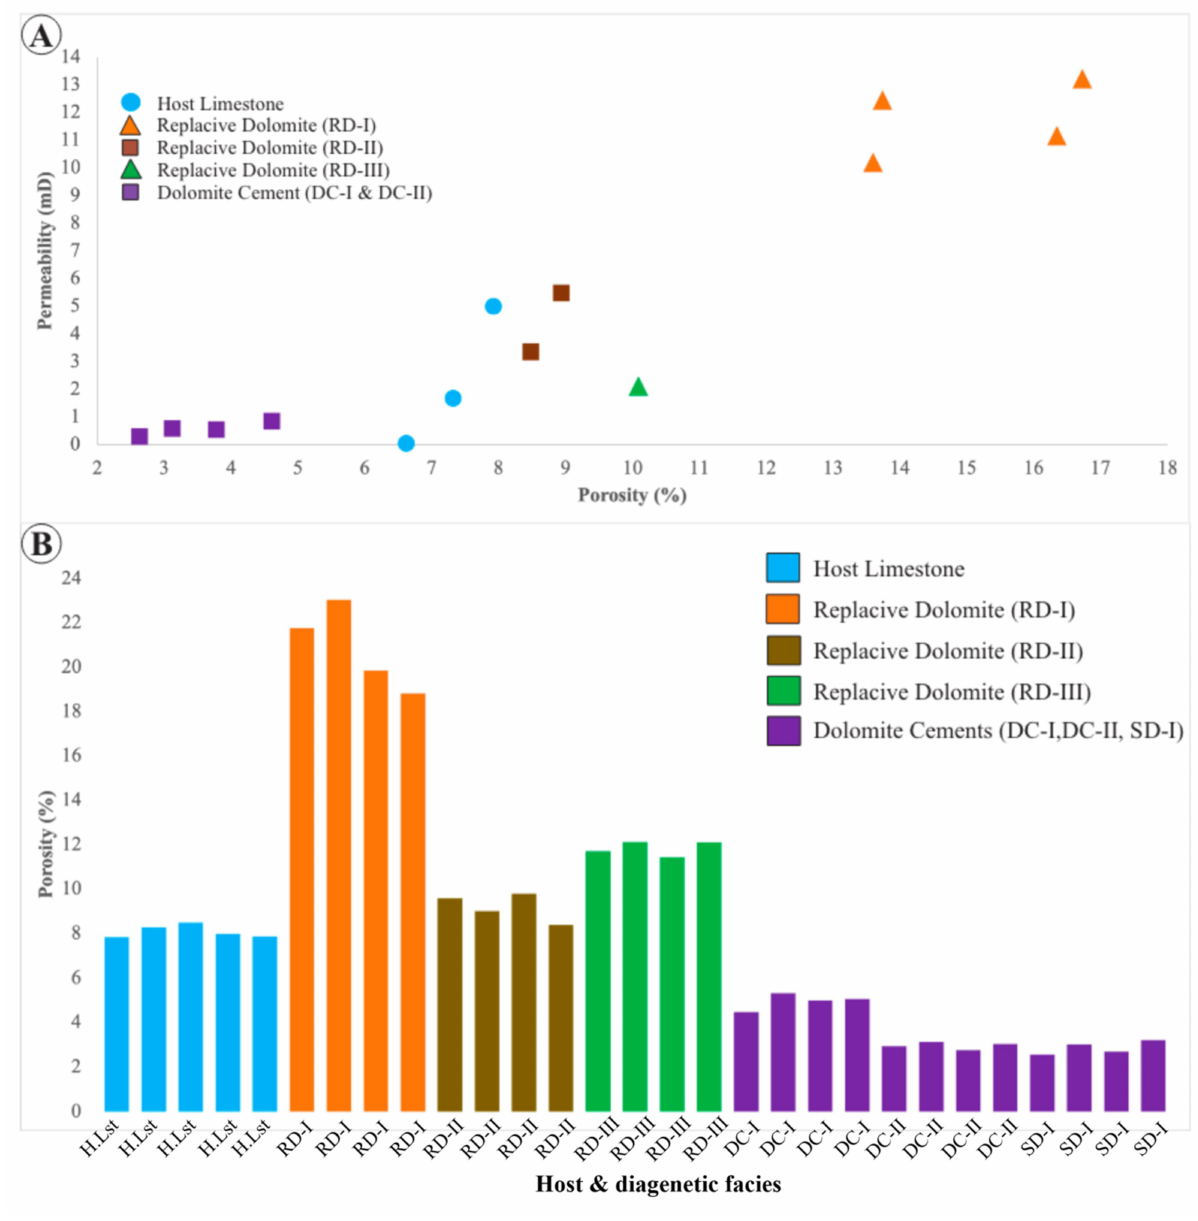
Figure 10. ( A ) Illustrate graphical presentation of porosity and permeability values for different diagenetic phases obtained from plug analysis. ( B ) Explains the porosity values of different dolomite phases acquired from ImageJ